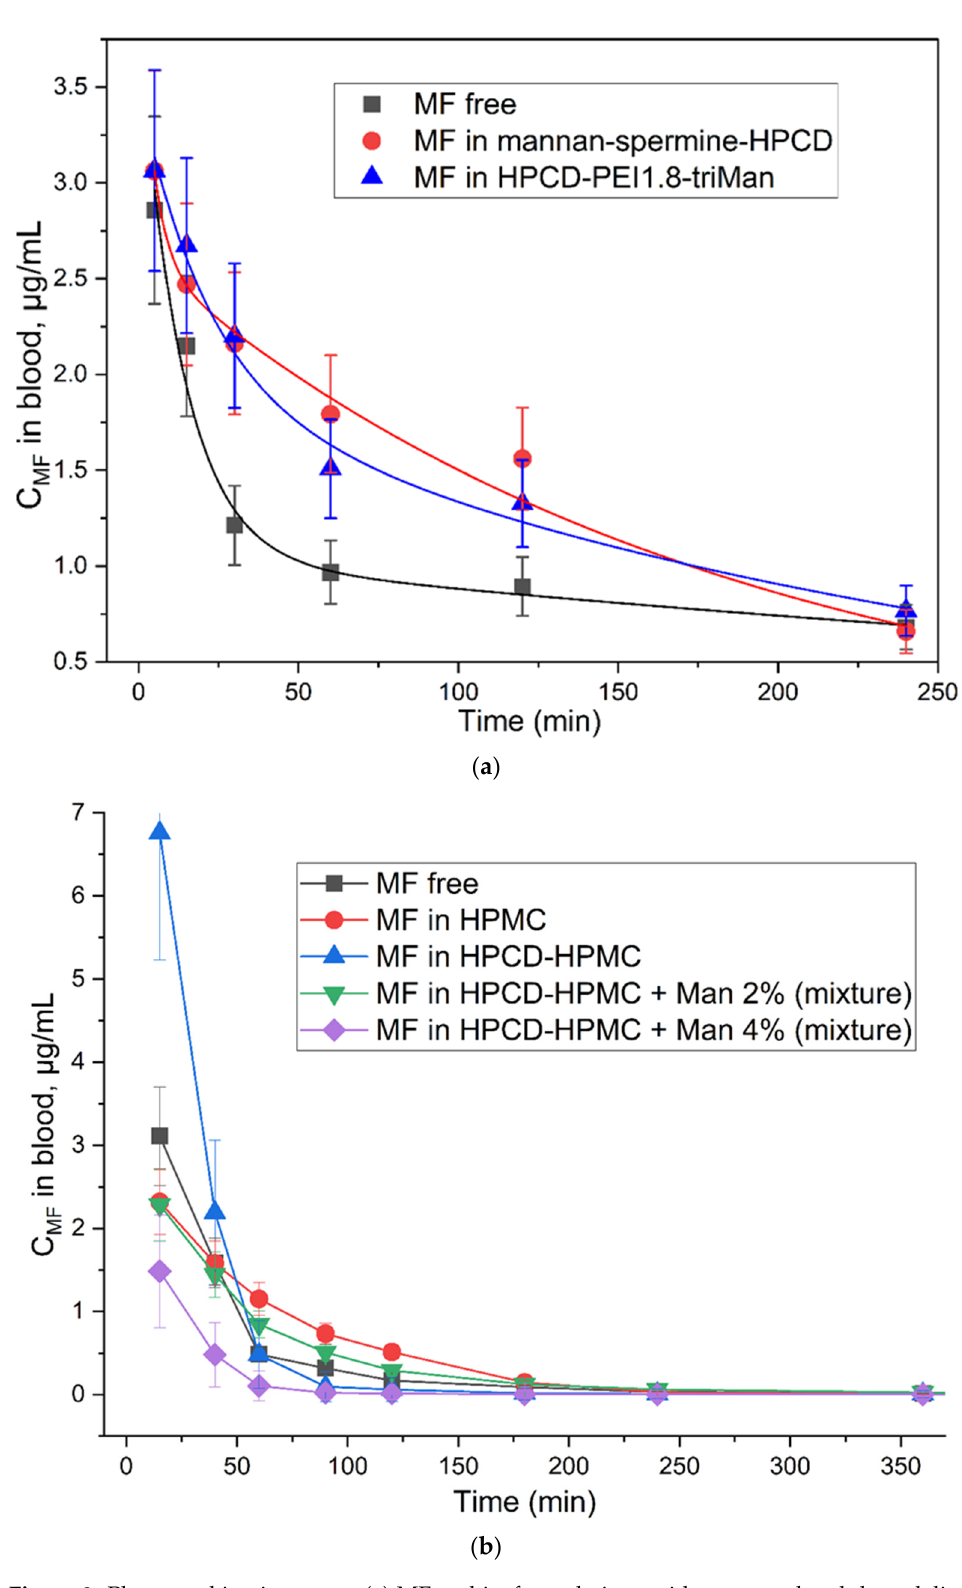
Figure 8. Pharmacokinetic curves: ( a ) MF and its formulations with mannosylated drug delivery systems in white mongrel rats; ( b ) MF and its formulations with HPMC in Wistar rats.